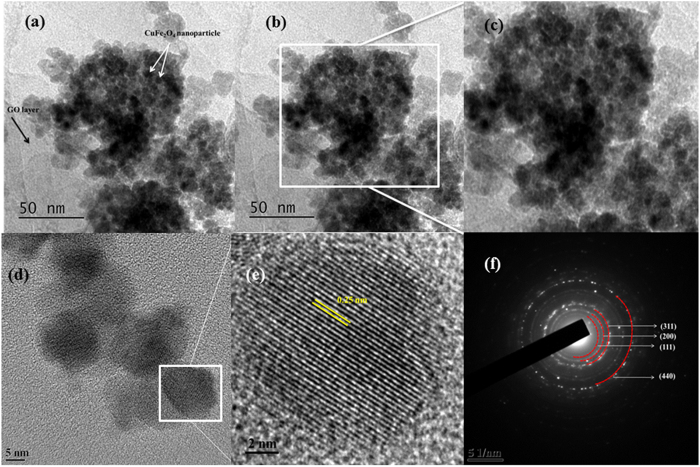
(a–e) TEM image of GO-CuFe2O4 nanocomposite at different magnification, (f) SAED image of GO-CuFe2O4 nanocomposite.